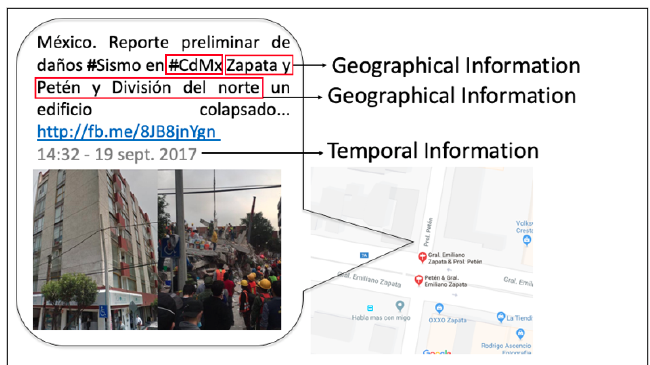
Figure 2. A tweet providing the location (spatial information) of a collapsed building, along with a timestamp (temporal information), one day after the 2017 earthquake in Mexico City. The message translated to English is: Mexico. Preliminary damage report #Earthquake in #CdMx Zapata and Peten and Division del Norte collapsed building... It is worth noticing that some users mention places using hashtags. In this example a hashtag #CdMx was used to refer to Mexico